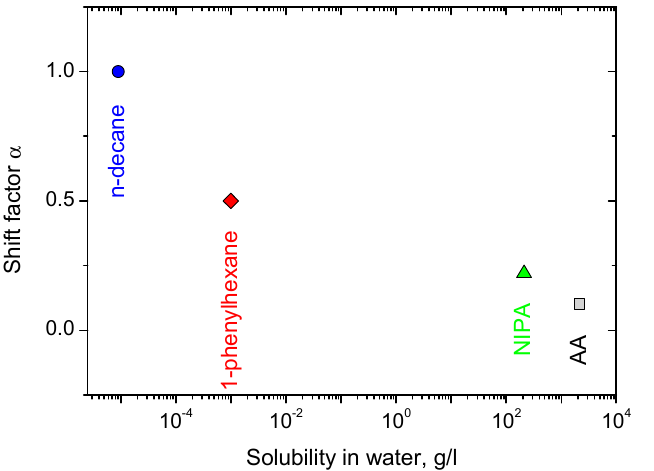
Figure 3. Dependence of the shift factor of the viscosity α on the solubility of the additive in water. If molar ratios [additive]/[surfactants] are used instead of the volume ratios, all the curves may also be superimposed (Figure S3a), and their general view does not